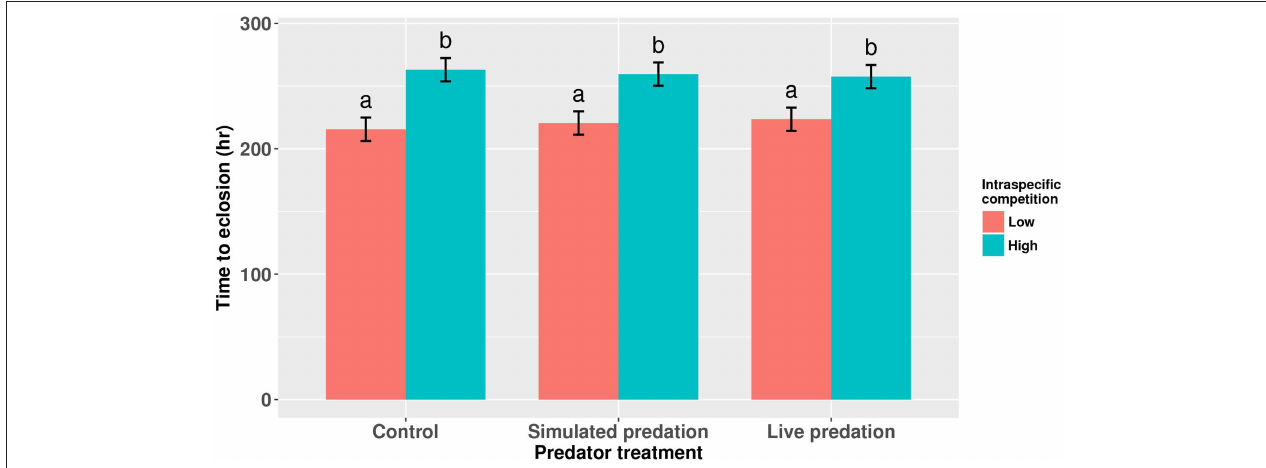
FIGURE 2 | Development time of cohorts of female Aedes aegypti larvae exposed to intraspecific competition and predator treatments. Values plotted are least squares means ± 95% CI. Data were statistically tested using ANOVA and significant effects are described in Table 2 . Treatment means associated with the same letters are not significantly different in pairwise comparisons using Bonferroni adjustment for multiple tests.